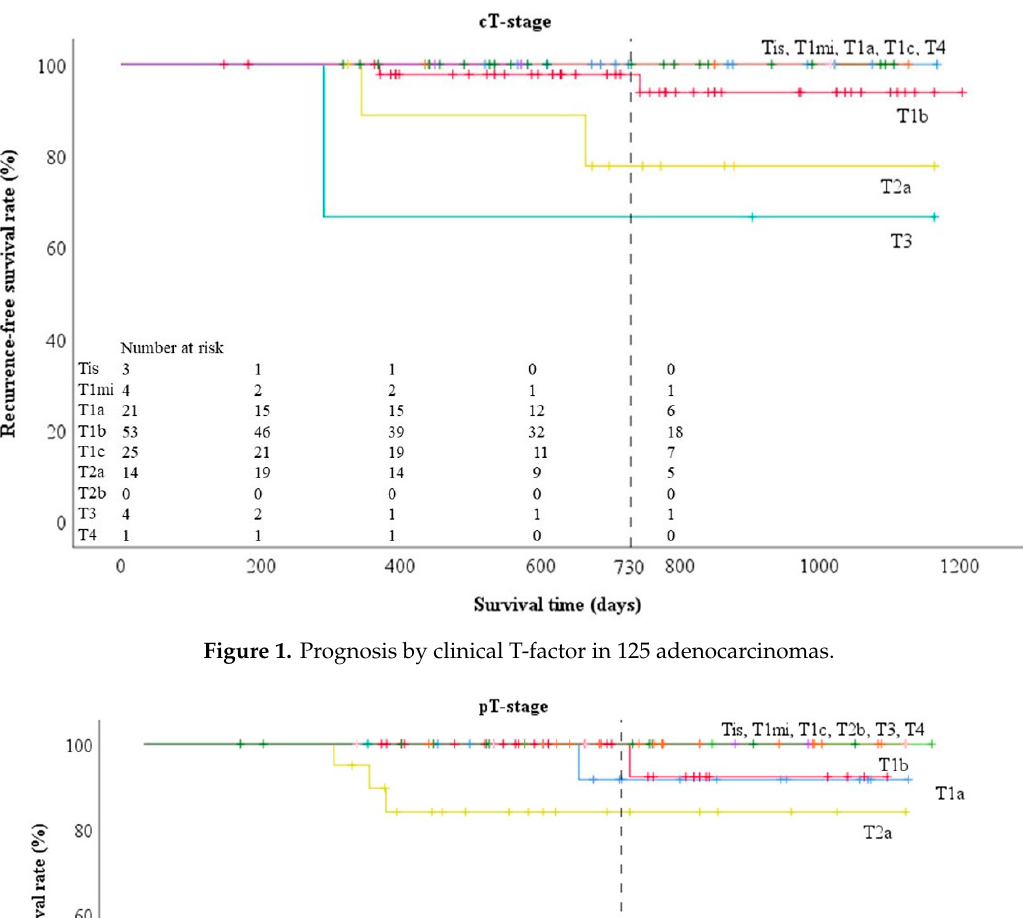
Table 7. Number of cases changed from clinical T-stage to pathological T-stage in 125 adenocarcinomas. Clinical T-Stage